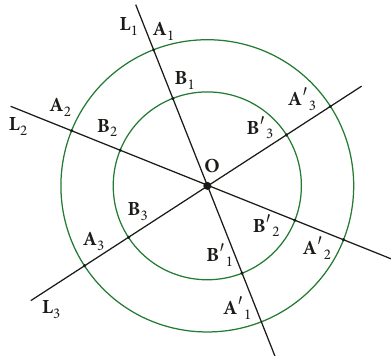
Figure 1: Calibration template showing the concentric circles and the three lines L 𝑖 (𝑖 = 1, 2, 3) that pass through their